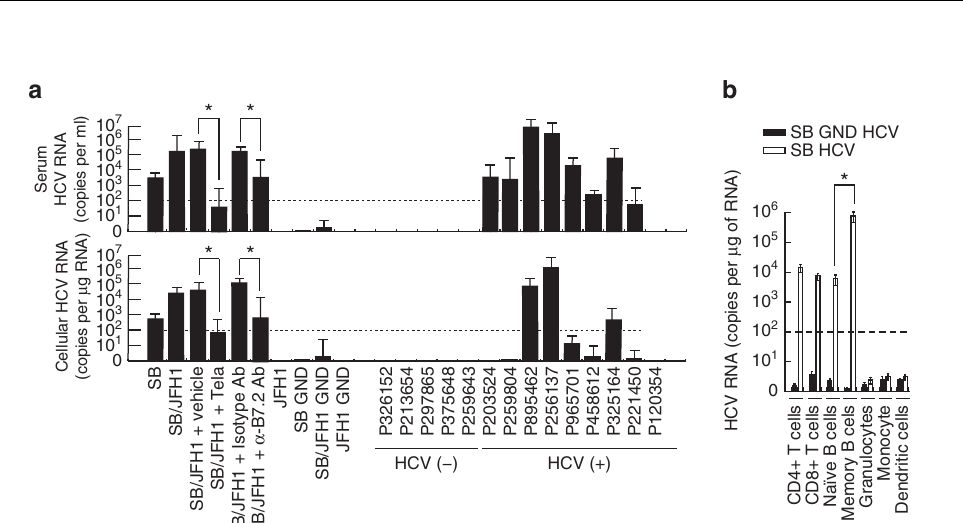
Figure 8 | A humanized mouse model engrafted with human hematopoietic cells was utilized to show HCV infection of human lymphomononuclear cells in vivo by the lymphotropic HCV strain. ( a ) HCV infection in immunocompromised Rag2;Il2rg (cid:2) / (cid:2) (RG) mice engrafted with human hematopoietic stem cells (RG-hu HSC Mice) shows that the two HCV strains, SB and JFH-1, have different tissue-specificity. HCV RNA levels in serum and PBMCs isolated from RG-hu HSC mice at 70 days after HCV inoculation were determined by RT-qPCR. Tela: telaprevir (HCV NS3 inhibitor) treatment. (* P o 0.05, t -test, n ¼ 3). Error bars represent s.d. ( b ) Human PBMCs from the infected RG-hu mice collected at 70 days after HCV inoculation were separated into various cell types and analysed for the presence of HCV RNA Memory B cells have high cellular HCV RNA levels in comparison to that of naı¨ve B cells. (* P o 0.05, t -test. n ¼ 3). Error bars represent s.d.